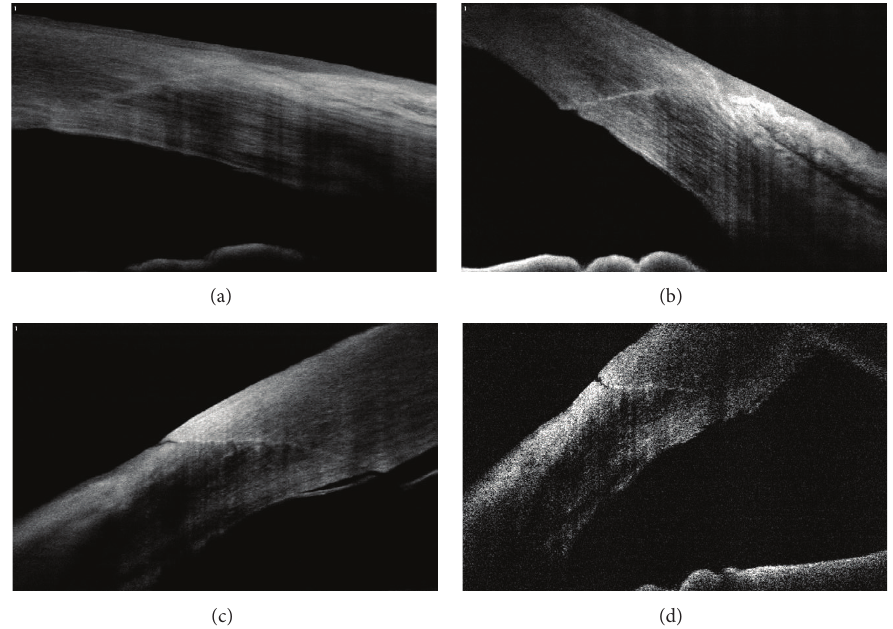
Figure 5: Architectural analysis of cataract surgery. Well apposed corneal wound (1 plane) (a), loss of cooptation with minimal endothelial misalignment (2 plane) (b), minimal Descemet’s membrane detachment with epithelial gap (2 plane) (c), and loss of cooptation with endothelial gap (3 plane)